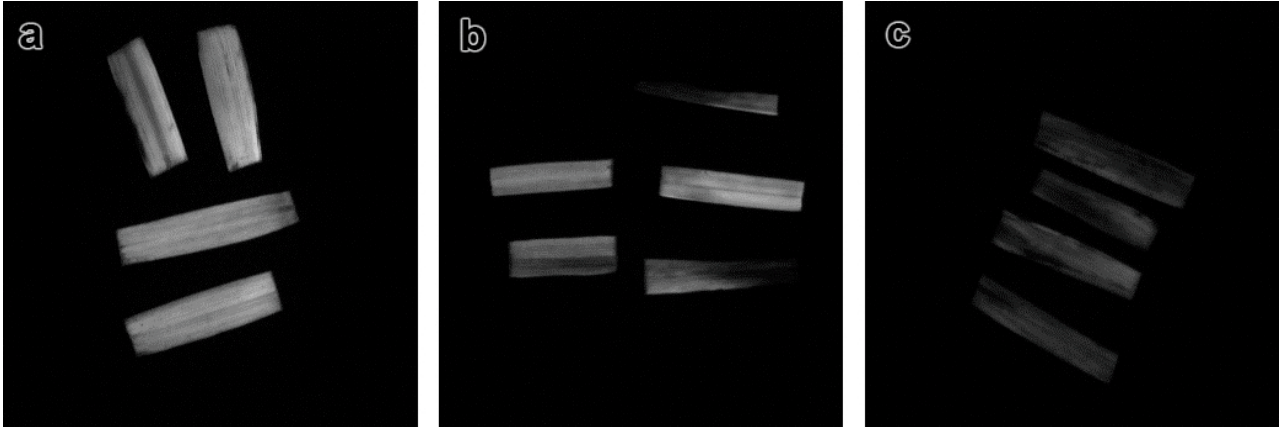
Figure 6. Chlorophyll fluorescence of H. sativum leaves by video registration. ( a ) control, ( b ) 300 mg/L ZnO NPs, ( c ) 2000 mg/L ZnO NPs .